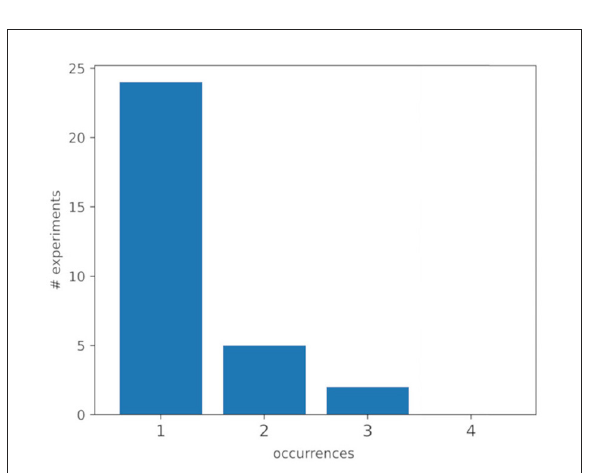
FIGURE2 This figure represents the occurrence distribution of the best 10 configurations (out of a total of 256 experiments), that is, with the highest PSNR values, on the four input